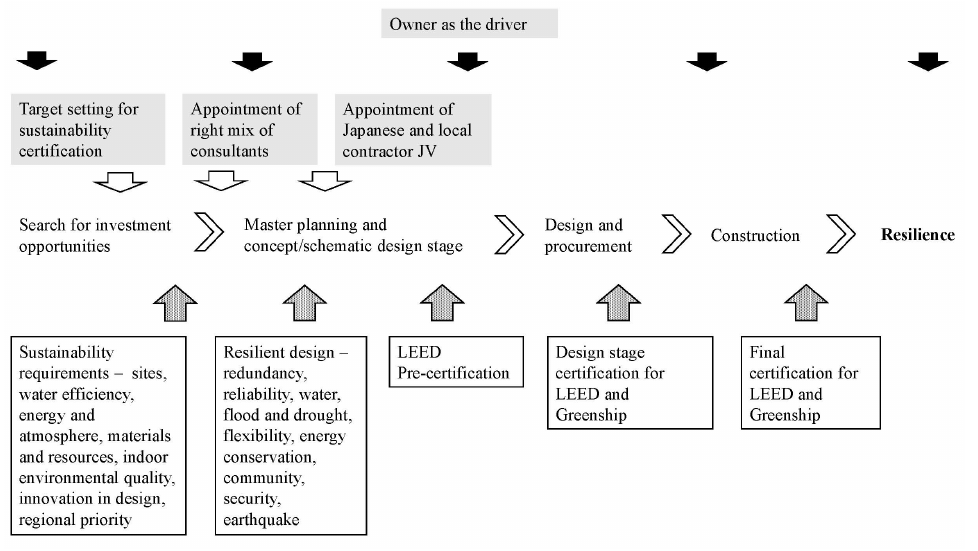
Figure 1. Approach to Sustainability and Resilience for PCP Jakarta